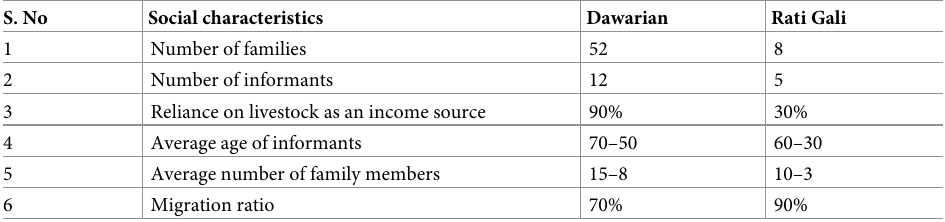
Table 1. Social characteristics of the variable samples between two study sites: Rati Galli and Dawarian of District Neelam of Azad Jammu and Kashmir. S.